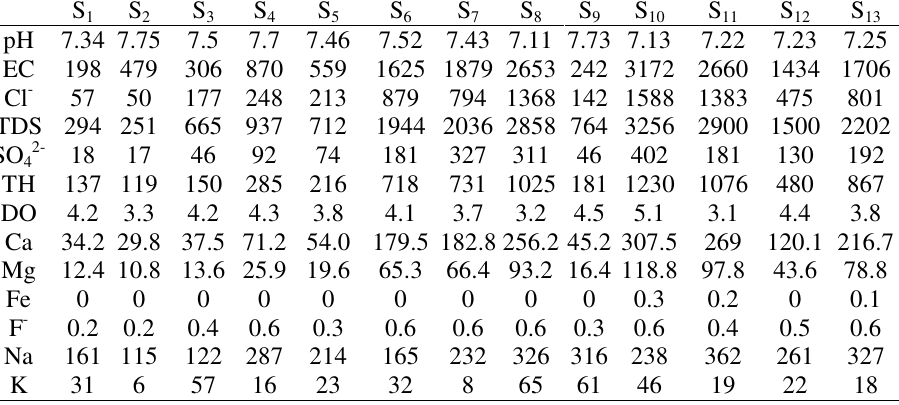
(All values in ppm except pH and